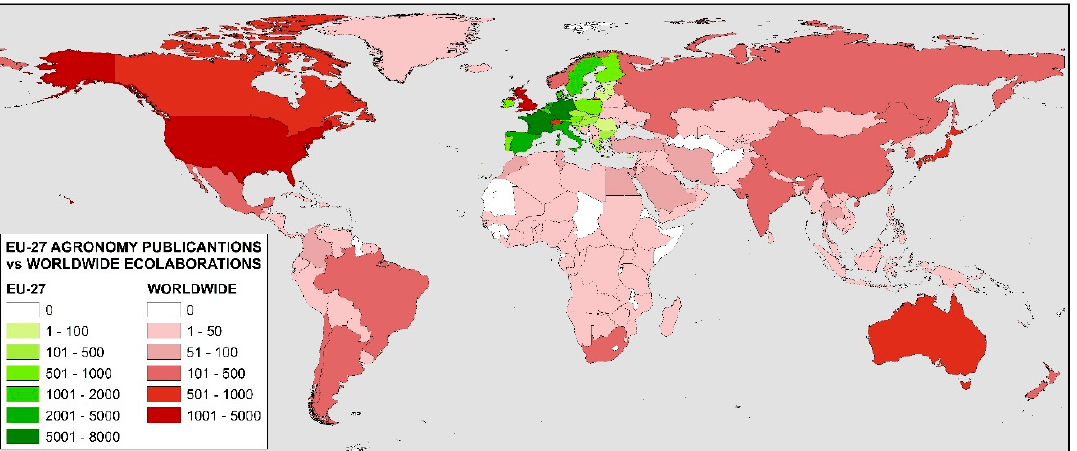
Figure 3. Worldwide production and collaboration of EU-27 publications cited in patents.